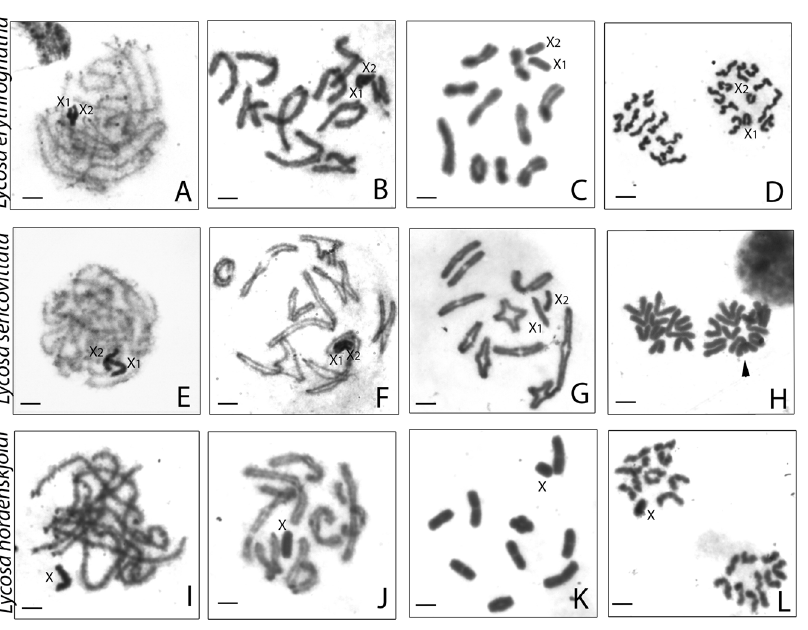
Figure 2 – Meiotic cells from Lycosa males stained with Giemsa. A-D Lycosa erythrognatha; E-H Lycosa sericovittata; I-L Lycosa gr . nordenskjoldi. Cells in pachytene ( A, E, I ) evidence the positive heteropycnotic sex chromosomes. Diplotene cells showing sexual univalents arranged side by side (B, F) or as an isolated univalent (J); all cells showing chiasmata, mostly terminal in autosomes. Diakinesis cells confirmed the number of bivalents and sex chromosomes in each species: ( C ) L. erythrognatha e ( G ) L. sericovittata with 10 autosomal bivalents + X 9 autosomal bivalents + X0. Metaphase II cells show joint migration of sex chromosomes ( D, H ) by observing cells with 12 and 10 chromosomes; and the migration of the single sex chromosome ( L ) showing cells with 10 and 9 chromosomes. The arrowheads in ( H ) indicate the cell with the highest chromosome number. Bar = 10 μm.